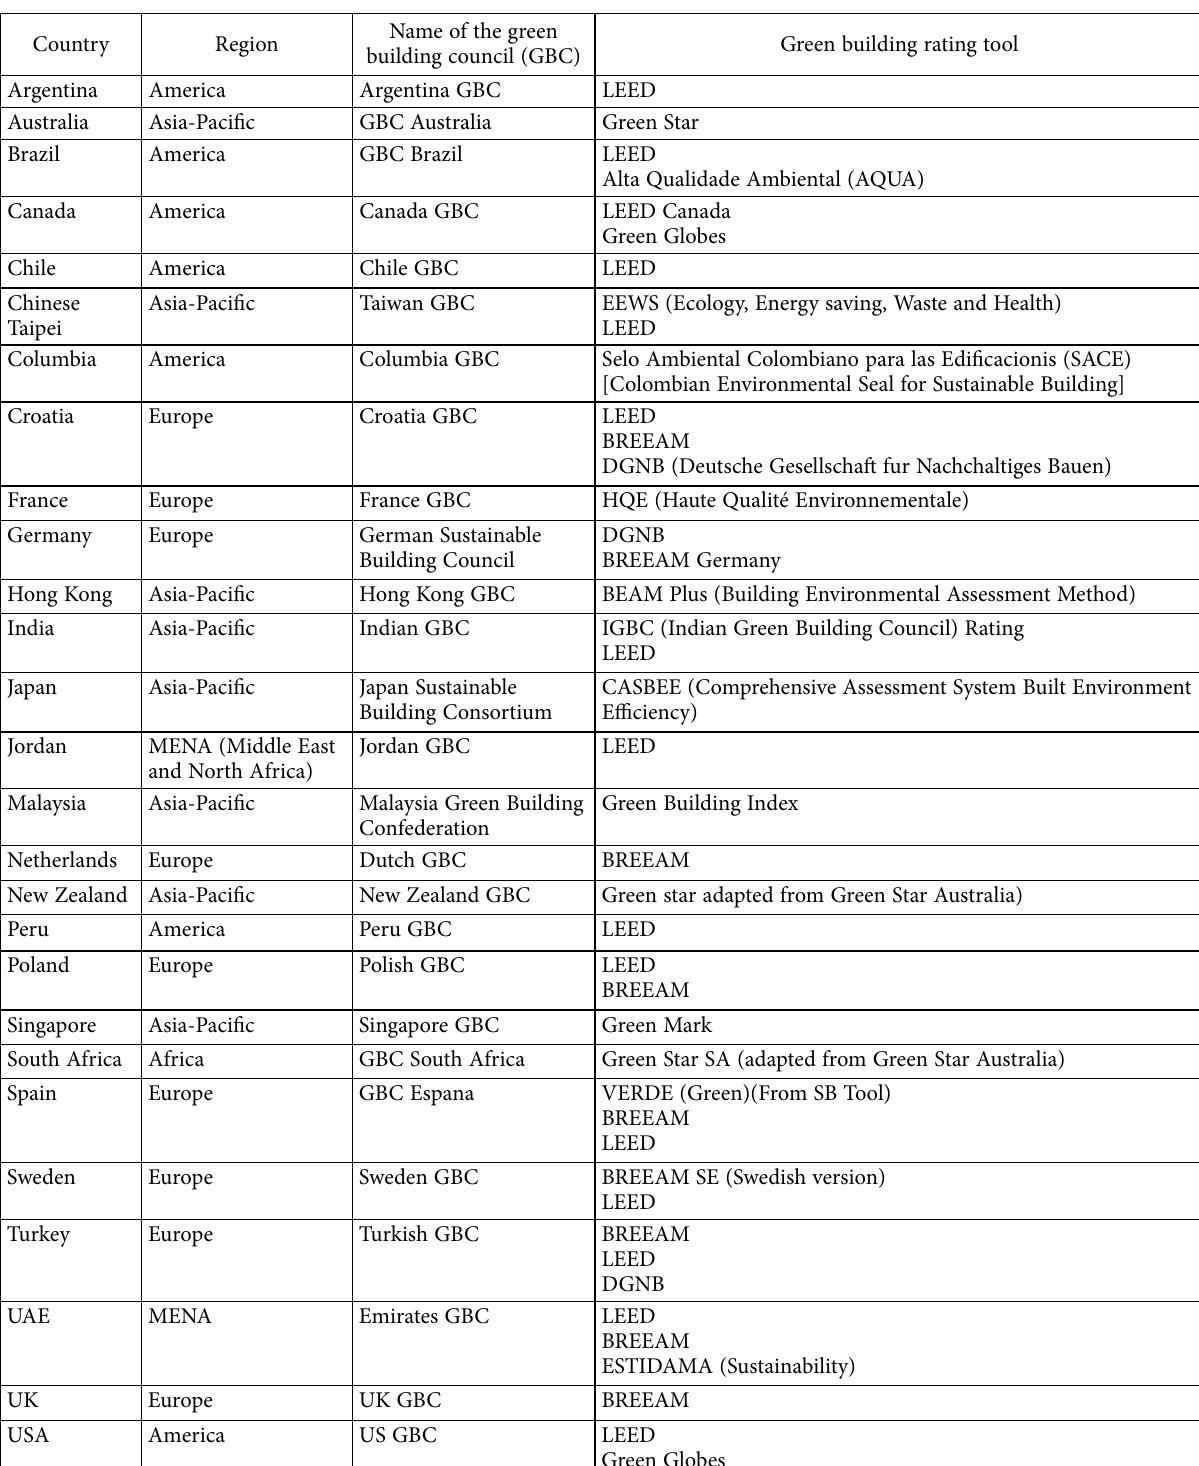
Table 1. Green building rating tools in different